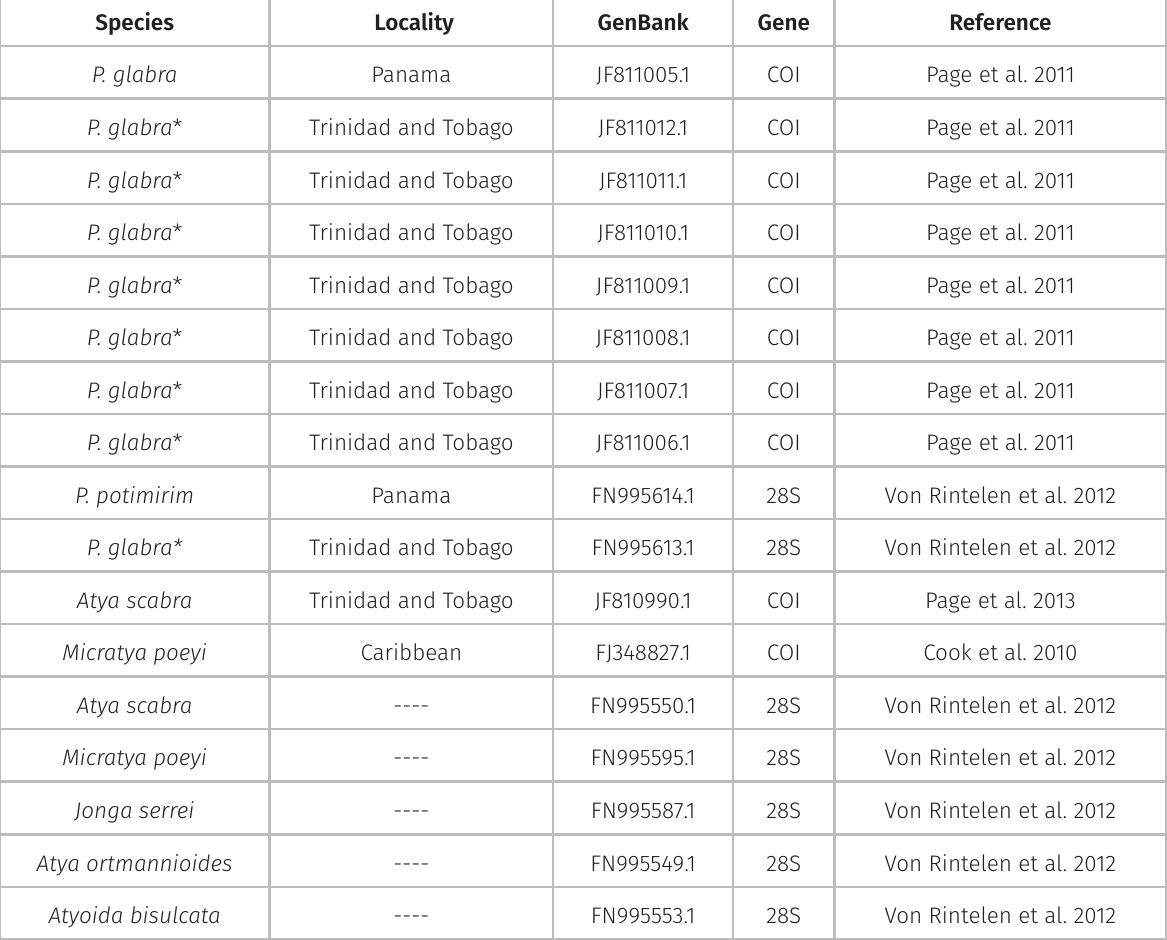
Table I. Data of the sequences obtained from GenBank. *Species named as P. glabra in GenBank, but posteriorly identified as Potimirim sp